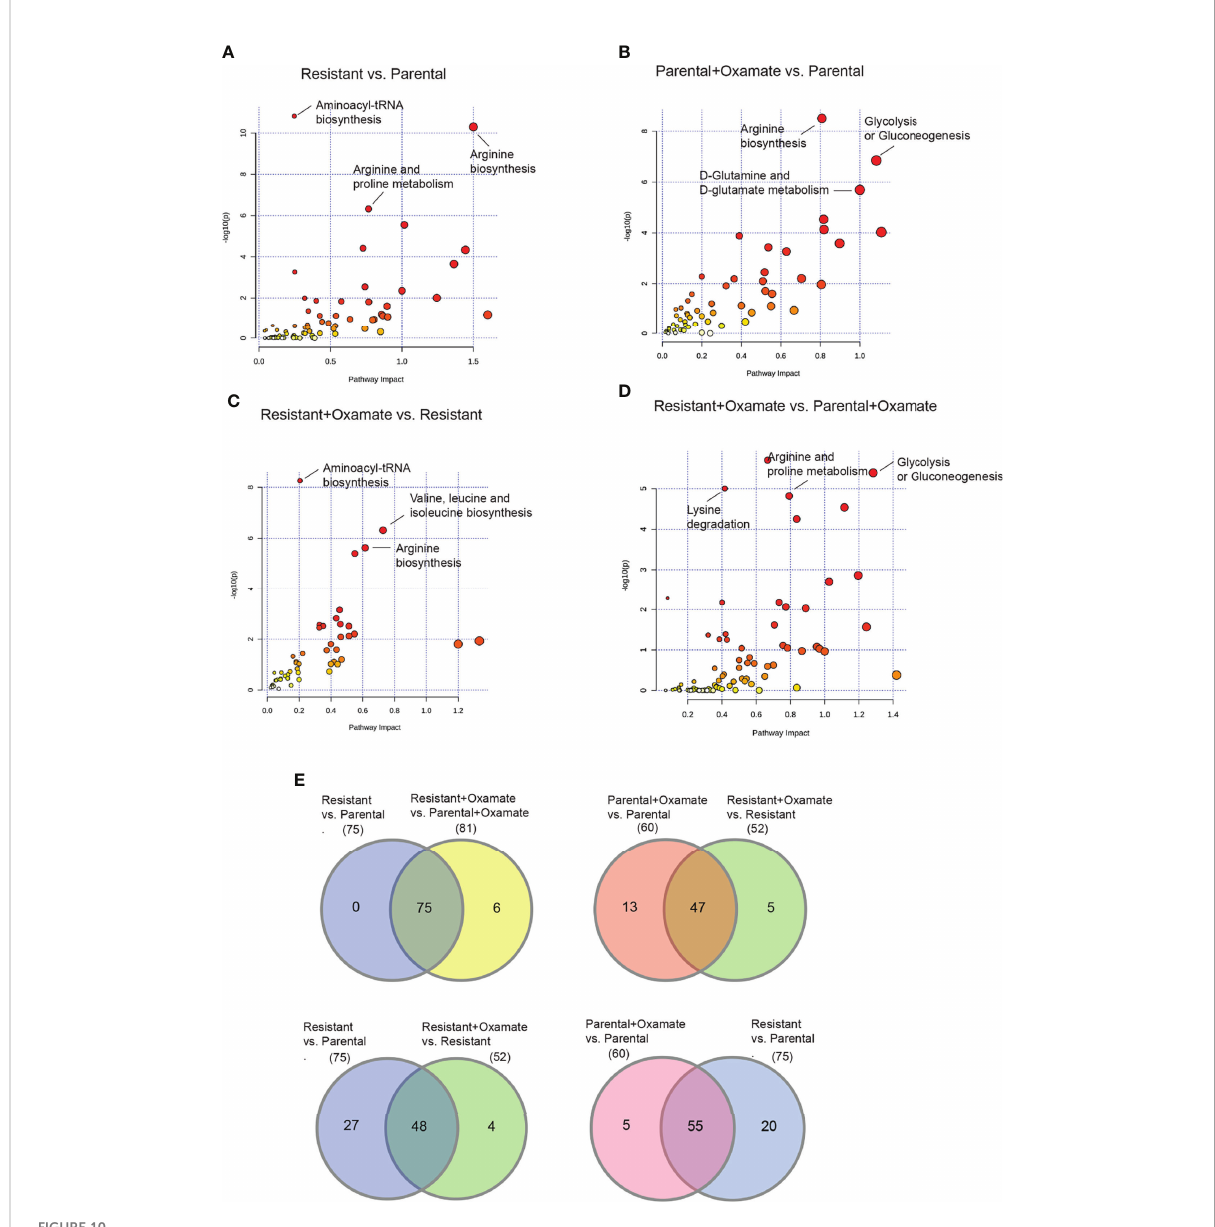
FIGURE 10 Integrative RNA-seq and metabolomics analysis identi fi es similarities and differences between parental and oxamate-resistant pancreatic cancer cells. (A) Integration of altered metabolic genes and metabolites was performed using the joint pathway analysis module of MetaboAnalyst 5.0 for the comparison between parental and oxamate-resistant MIAPaCa2 cells. (B) Integration of altered metabolic genes and metabolites was performed using the joint pathway analysis module of MetaboAnalyst 5.0. for the comparison between vehicle- and oxamate-treated parental MIAPaCa2 cells. (C) Integration of altered metabolic genes and metabolites was performed using the joint pathway analysis module of MetaboAnalyst 5.0 for the comparison between vehicle- and oxamate-treated oxamate-resistant MIAPaCa2 cells. (D) Integration of altered metabolic genes and metabolites was performed using the joint pathway analysis module of MetaboAnalyst 5.0 for the comparison between oxamate-treated parental and oxamate-treated oxamate-resistant MIAPaCa2 cells. (E) Venn diagram for the indicated comparisons showing differentially altered metabolic pathways based on the integrative analysis of differentially expressed metabolic genes identi fi ed by RNA-seq and differential metabolites identi fi ed by the metabolomics analysis in the indicated